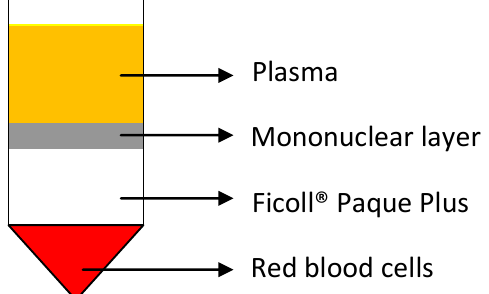
Figure 2 - Schematic diagram of the separation of the components of a blood sample from Ficoll ® Paque Plus density gradient